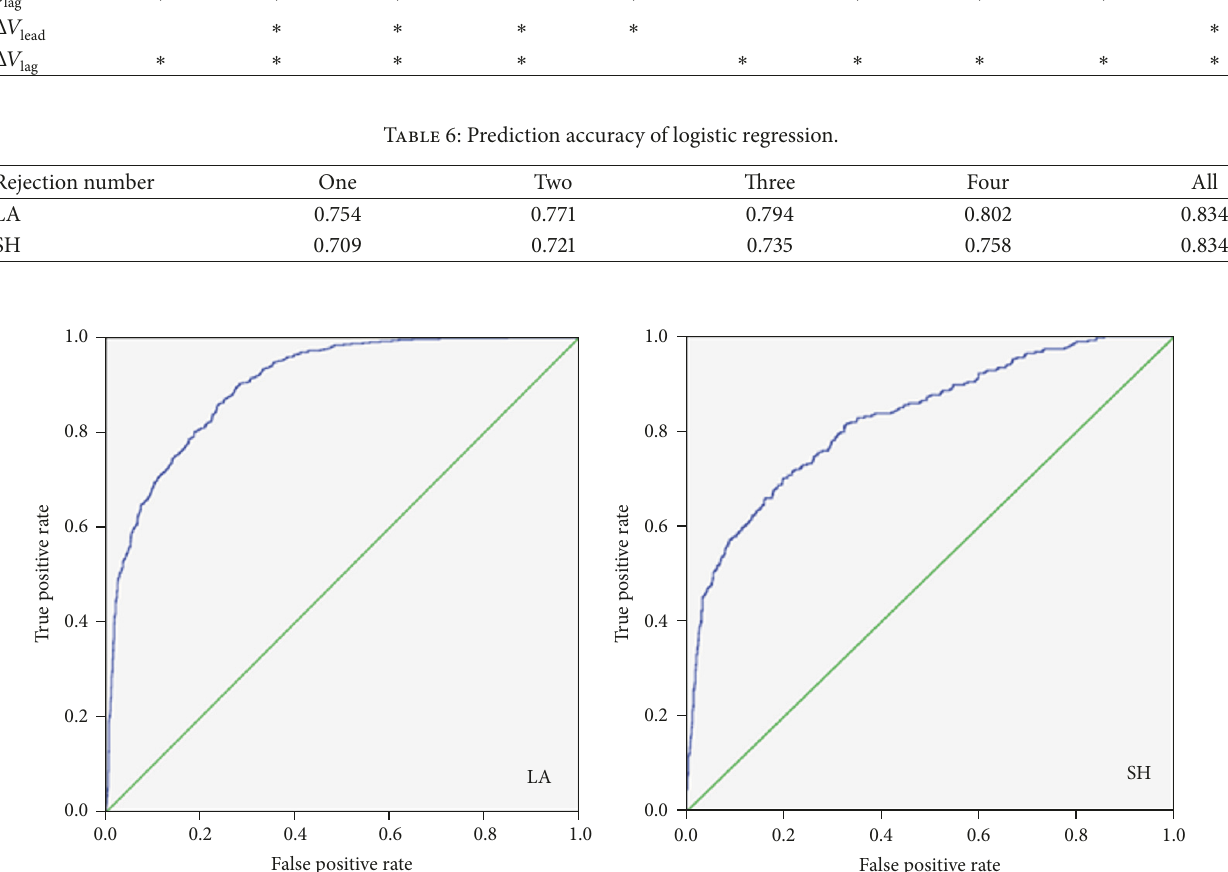
a relatively low accuracy. Meanwhile, Marczak et al. [7] used a different data set. We applied their method to our datasets, and the accuracy we obtained is only